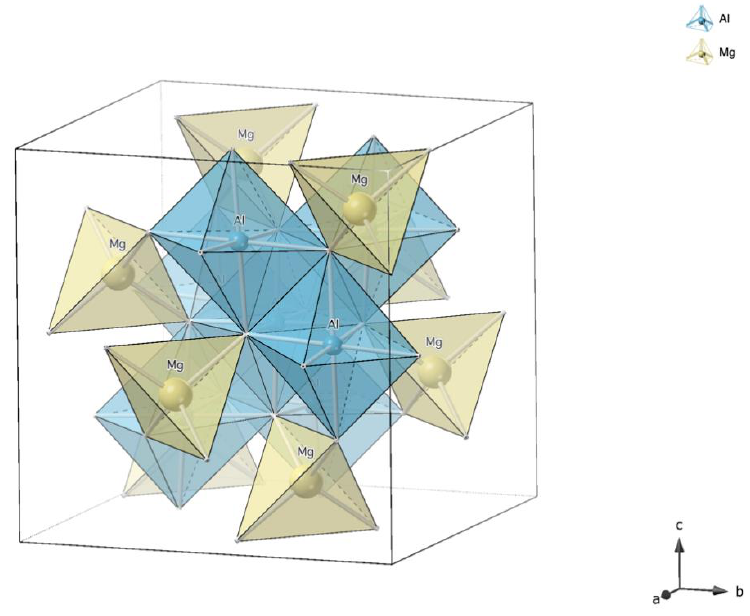
Figure 1. Schematic diagram of “normal” spinel MgAl 2 O 4 .